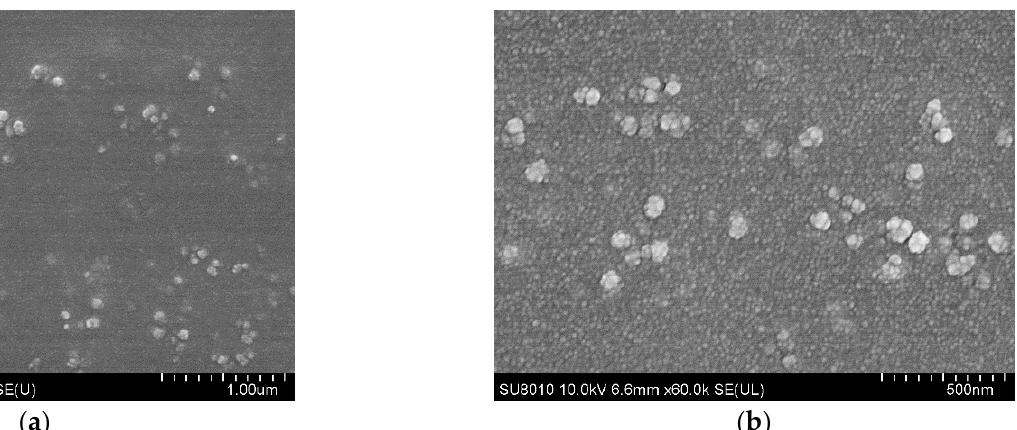
Figure 3. Release profile of rTgPSA1/CS nanospheres and rTgPSA1/IFA emulsion in vitro over a 16-day period. Amount of recombinant protein in supernatant was determined by BCA assay. Each sample was tested once. Values represented as mean ± SD (n = 3). 3.4. Antibody and Cytokine Production in Mice According to the standard ELISA procedure, the titers of total IgG and isotypes IgG1 and IgG2 in the sera collected from mice were investigated. As shown in Figure 4a, significantly increased levels of total IgG antibodies were found in rTgPSA1, rTgPSA1/IFA, and rTgPSA1/CS groups after the first (week two) and second (week four) immunizations, and mice immunized with rTgPSA1/IFA generated the highest level ( p < 0.01) of total IgG after the second immunization (week four). Furthermore, the sera sep- arated from animals also revealed higher titers of IgG1 (Figure 4b) and IgG2a (Figure 4c) after the first and second immunizations. Compared with the blank and control groups, animals immunized with rTgPSA1, rTgPSA1/IFA, or rTgPSA1/CS generated higher lev- els ( p < 0.001) of isotype IgG1 after the first (week two) and second (week four) immun- izations. As for isotype IgG2a, remarkable increases ( p < 0.001) were also observed in the rTgPSA1, rTgPSA1/IFA, and rTgPSA1/CS groups after the first (week two) and second (week four) immunizations. Furthermore, the rTgPSA1/IFA group secreted higher levels ( p < 0.05) of isotype IgG2a than the rTgPSA1/CS group. Strictly according to the instructions, the sera collected from animals after the sec- ond immunization (week four) were tested to determine the levels of IFN- γ , IL-4, IL-10, and IL-17. As demonstrated in Figure 5a,b, obviously higher levels of IFN- γ and IL-4 were detected in the rTgPSA1, rTgPSA1/IFA, and rTgPSA1/CS groups. However, all animals from immunized groups generated equivalent IL-10 ( p > 0.05; Figure 5c). As for IL-17, shown in Figure 5d, the secretions in animals immunized with rTgPSA1 and rTgPSA1/IFA were enhanced, while those in the rTgPSA1/CS group remained un- changed ( p > 0.05).